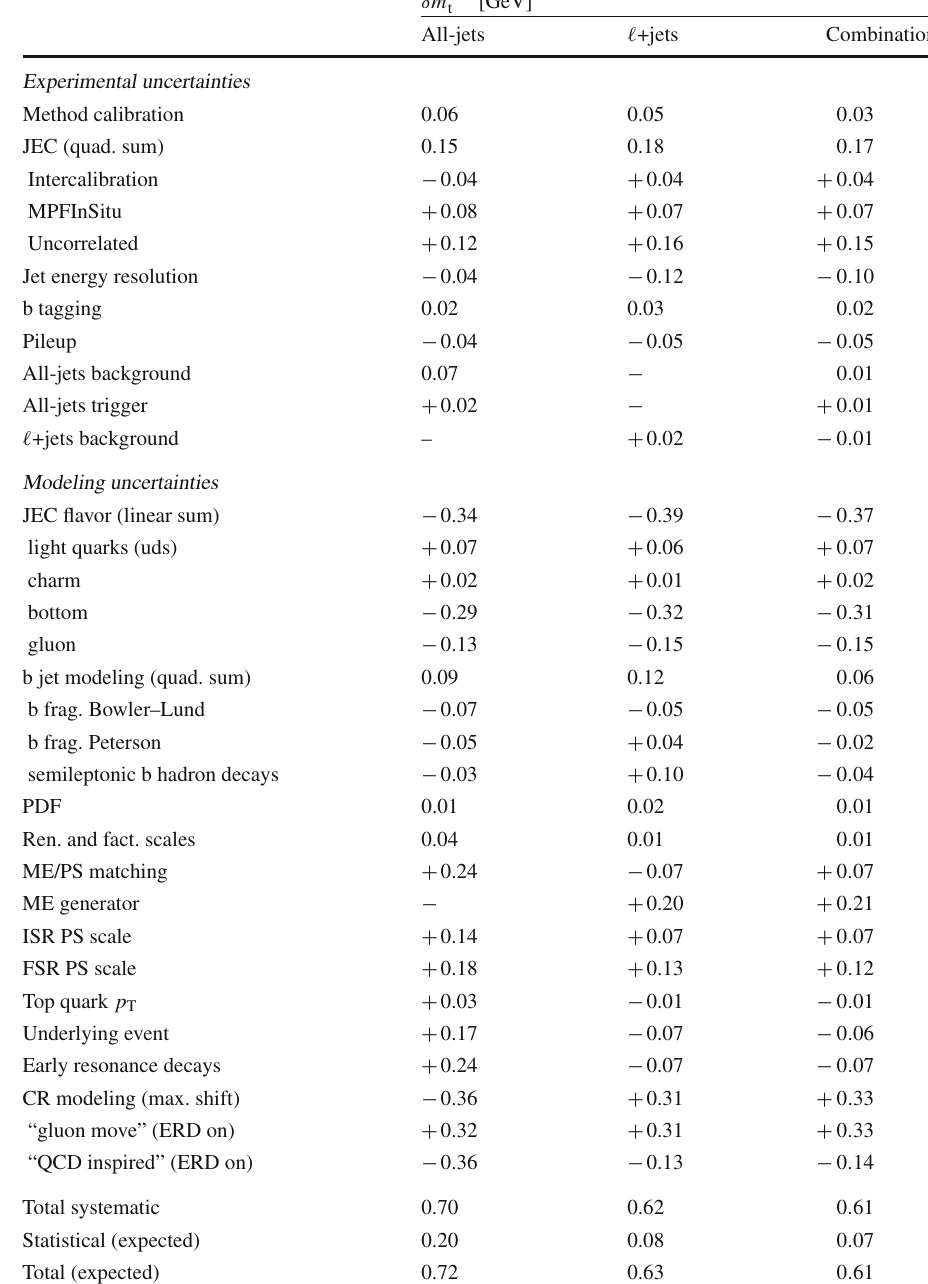
Table 3 Comparison of the hybrid mass uncertainties for the all-jets and lepton+jets [17] channels, as well as the combination. The signs of the shifts follow the convention of Tables 1 and